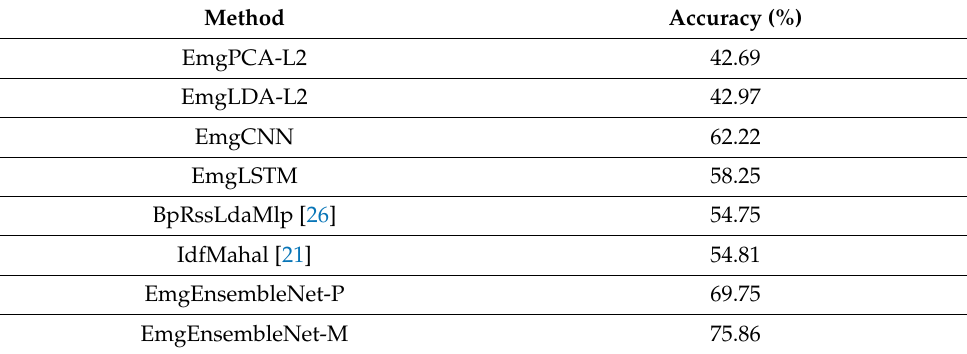
Table 5. Accuracies on Test data of CU-EMG-ECG dataset.